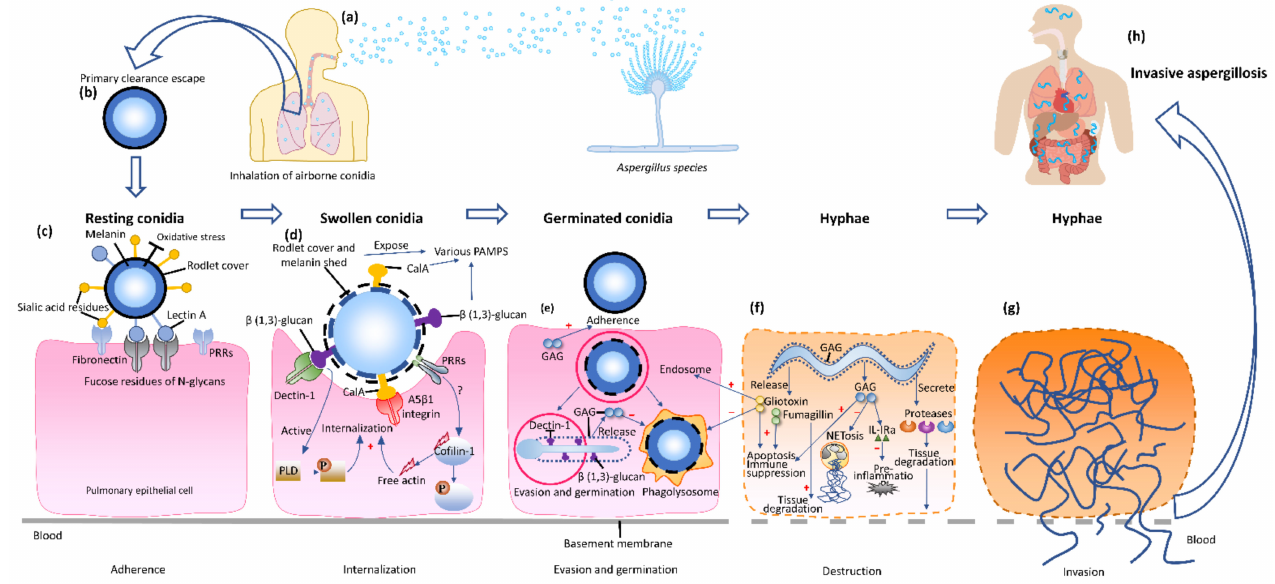
Figure 1. The pathogenesis of invasive aspergillosis. ( a ) Inhalation. Airborne conidia are inhaled into the respiratory system of the immunosuppressed host. ( b ) Clearance escape. The resting conidia escape primary clearance and immune attack. ( c ) Adherence. The rodlet protein cover and melanin of the resting conidia mask the pathogen-associated molecular patterns (PAMPs) and protect the conidia from oxidative stress and the environment (UV) and host (reactive oxygen species, ROS), and from being recognized and attacked by the host. Lectin A and sialic acid residues mediate the adherence and colonization onto the fucose residues of N-glycans and fibronectin of the pulmonary epithelial cells. ( d ) Internalization. The swollen conidia release the surface hydrophobic layer and melanin, exposing more PAMPs, such as β (1-3)-glucan and calcineurin A (Cal A), to be recognized by dectin-1 and integrin α 5 β 1, respectively, on the epithelial cell wall, inducing the internalization. In addition, the formation of actin polymerization and activation of phospholipase D (PLD) both boost the internalization. ( e ) Evasion and germination. The swollen conidia in the endosome evade the phagolysosome killing and germinate into tubes and hyphae. Galactosaminogalactan (GAG) on the hyphae wall can be released as a soluble molecule, mediating adhesion, inhibiting phagocytosis and suppressing the host inflammatory responses by masking of β (1,3)-glucan on the hyphal wall. ( f ) Destruction. GAG released by mature hyphae facilitates the induction of neutrophil apoptosis and prohibits formation of neutrophil extracellular traps (NETosis), and pre-inflammation by induction of IL-IRa. The secreted gliotoxin and fumagillin are involved in pathogen internalization, cell apoptosis, host immune inhibition and tissue degradation. ( g ) Invasive aspergillosis. The tissue-invasive hyphae penetrate the alveolar epithelia and basement membrane into the blood vessel, disseminating to the whole body and causing IA ( h ). +: promote; − :